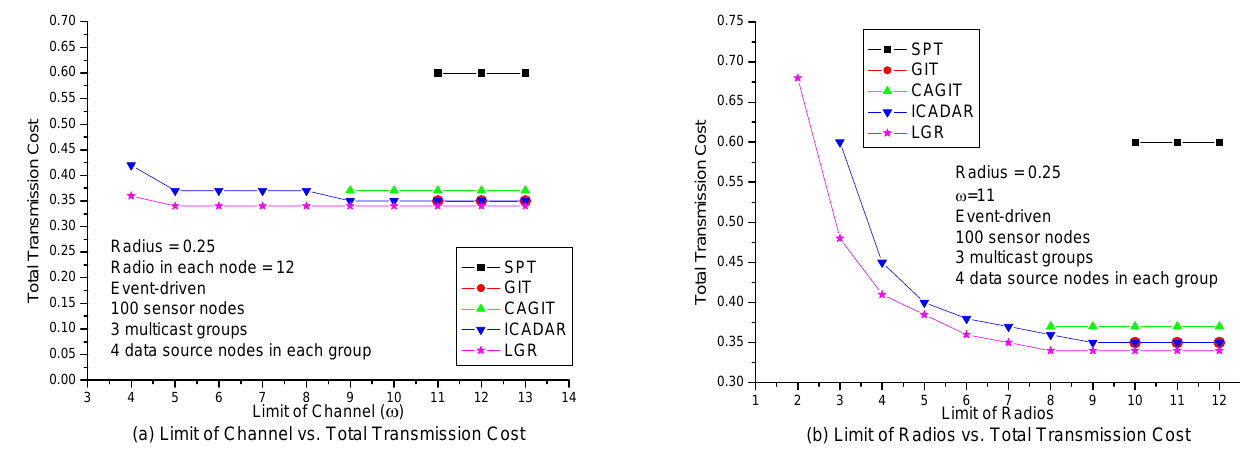
Figure 8. Performance comparison with respect to the channel and radio in